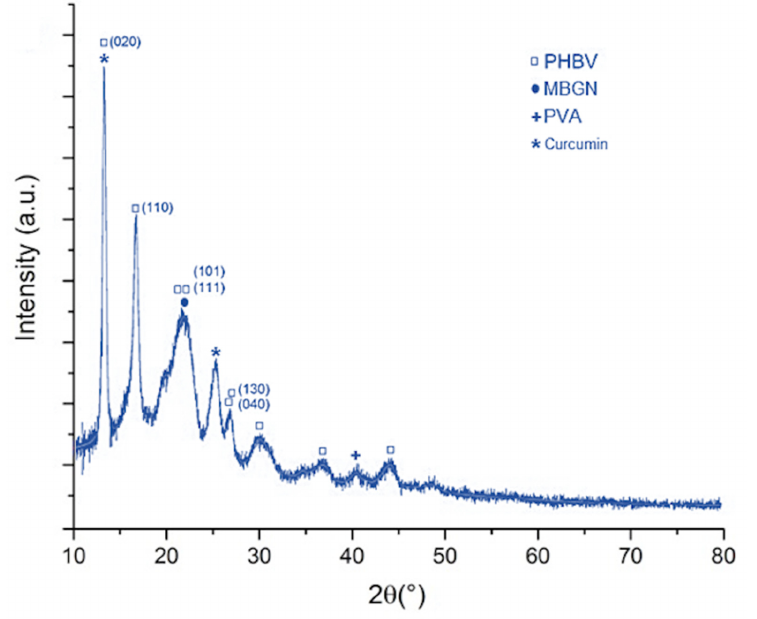
Figure 4. XRD pattern of a composite microsphere (70:30 PHBV/MBGN ratio). The identified peaks are discussed in the text.